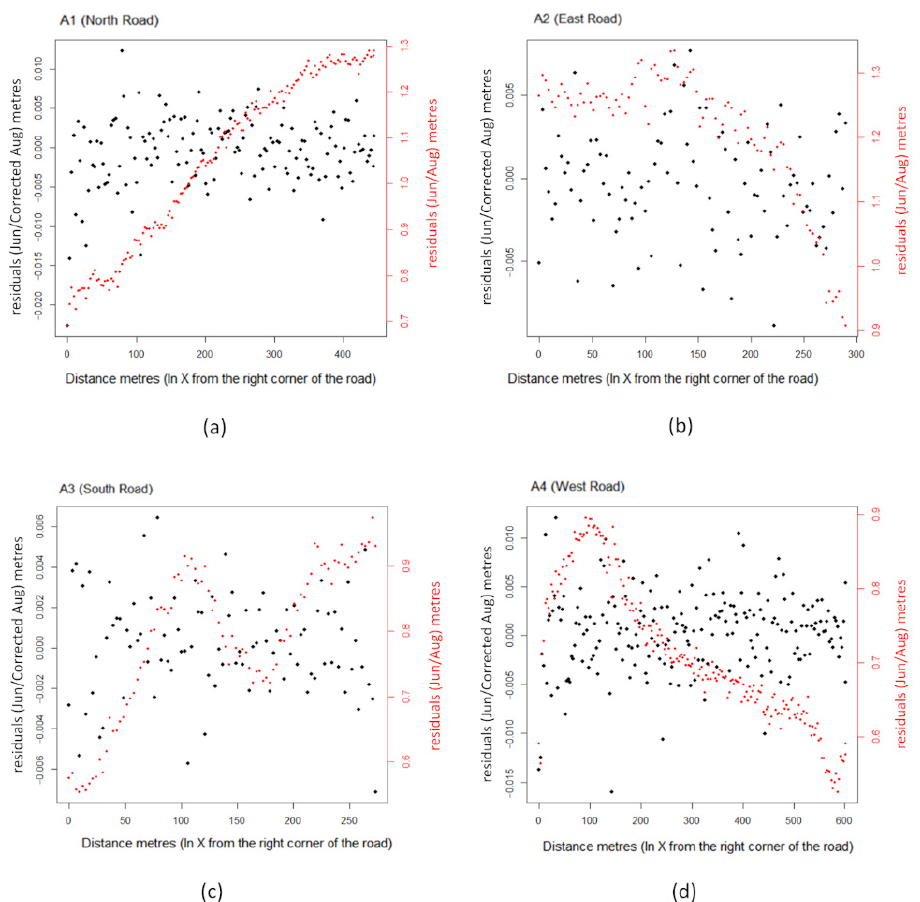
Figure 13. Residual plots for each unchanged area (point distance of profiles were filtered for a distance of 3 m): north vertical error profiles ( a ), east vertical error profiles ( b ), south vertical error profiles ( c ), and west vertical error profiles ( d ). Black dots represent the vertical errors between the corrected August DTM (estimated) and the June DTM, and red dots represent the vertical errors between the August DTM (observed) and the June DTM. Table 7. Statistical values for vertical errors (Corrected August DTM–June DTM) of unchanged areas (values in